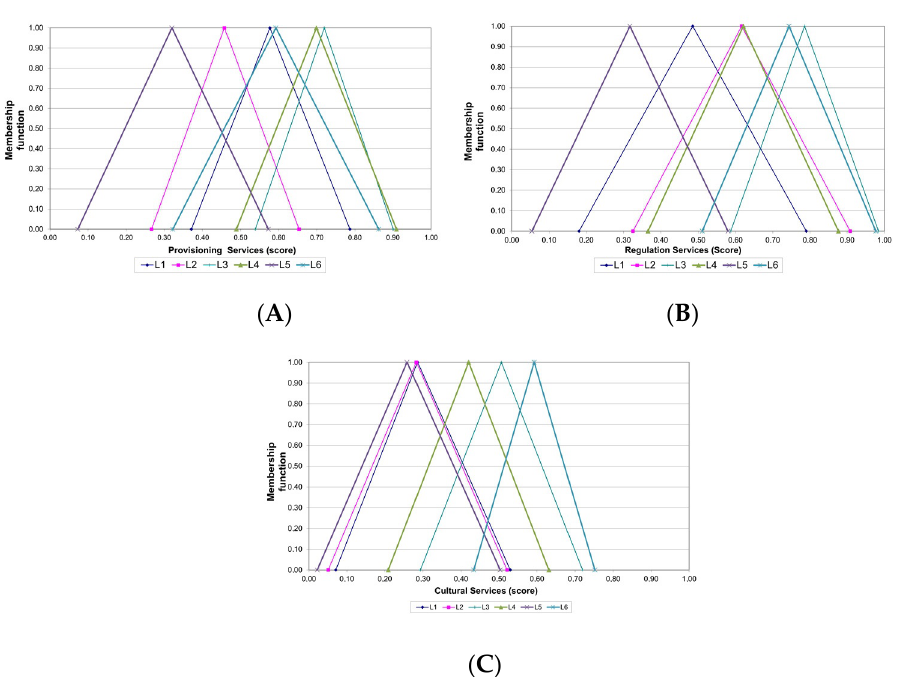
Figure 5. Landscape contribution to ES dimensions (provisioning: panel ( A ), regulation: panel ( B ), and cultural and amenity: panel ( C )).